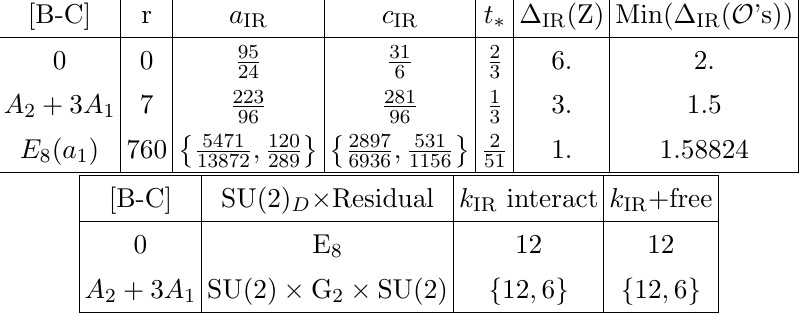
Table 13. Plain nilpotent mass deformations of the Minahan-Nemeschansky theory with E 8 (cid:13)avor, only rational values. The top table has the central charges a IR and c IR as well as scaling dimensions while the table below contains the information about the (cid:13)avor central charges.